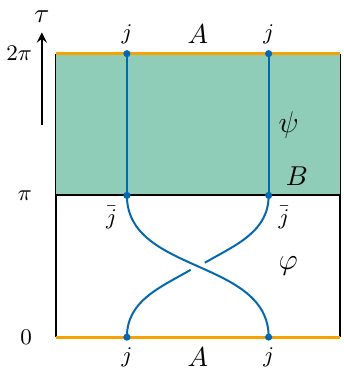
for the case with two A